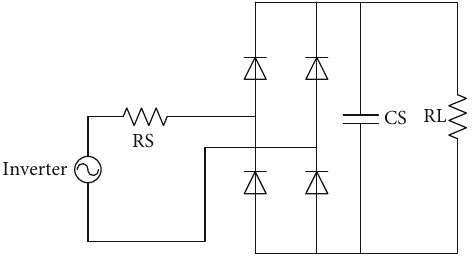
Figure 16: Nonlinear load test. RL = 272 Ω , CS = 458 μ F , and RS = 4 : 8 Ω